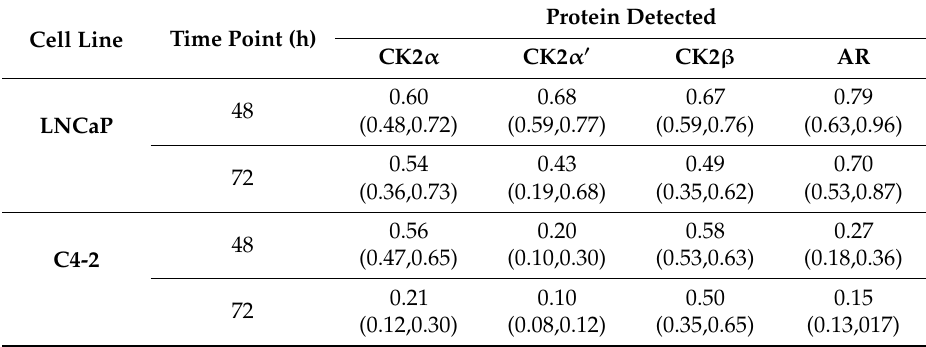
Table 2. Fold-change in protein level due to siRNA-mediated CK2 down-regulation.